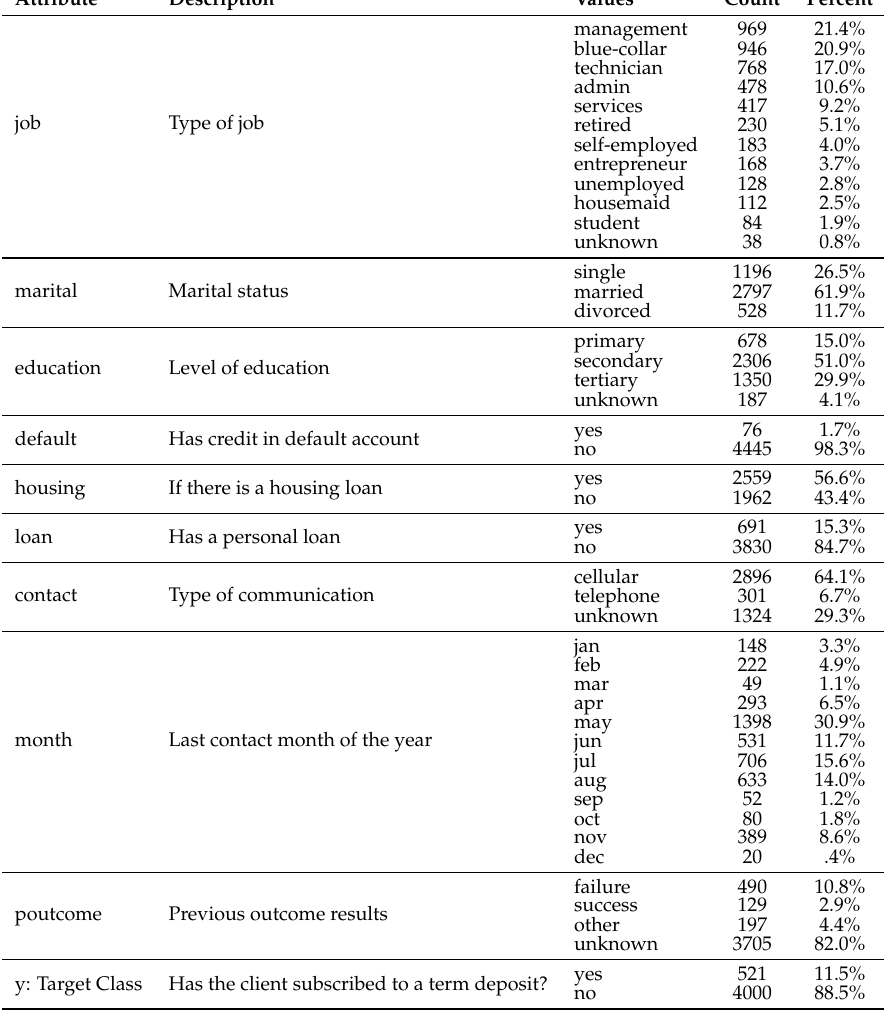
Table 1. Nominal Variables (Portuguese Bank dataset